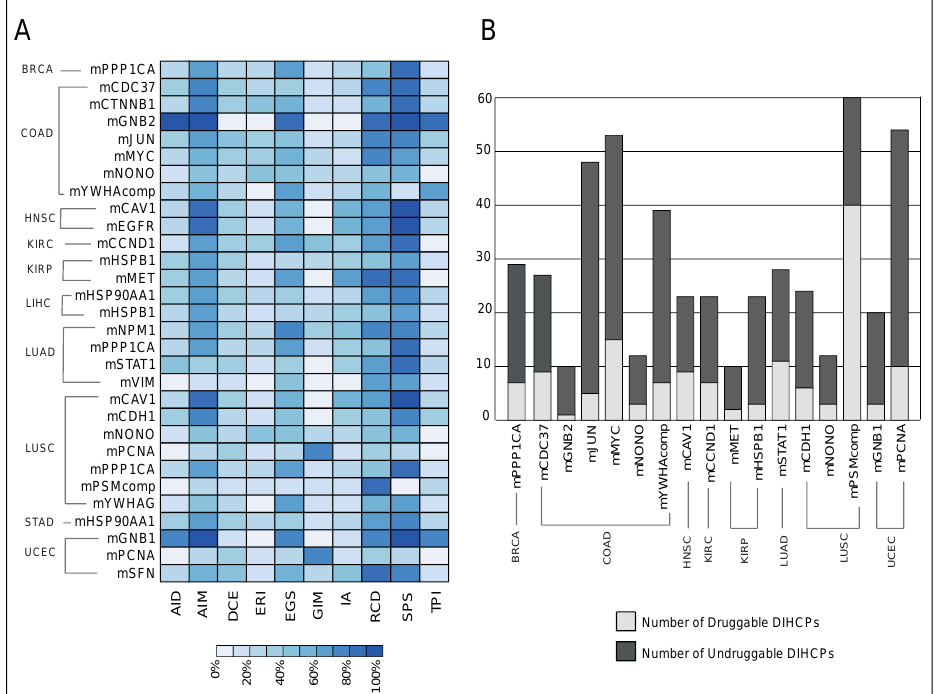
Figure 8. The hallmark enrichment and druggability analyses results. ( A ) The heat-map represents the hallmark enrichment results of the module’s differentially interacting hallmark of cancer proteins (DIHCPs). AID: avoiding immune destruction; AIM: activating invasion and metastasis; DCE: deregulating cellular energetics; ERI: enabling replicative immortality; EGS: evading growth suppressors; GIM: genome instability and mutation; IA: inducing angiogenesis; RCD: resisting cell death; SPS: sustaining proliferative signaling; TPI: tumor-promoting inflammation. ( B ) The druggability distribution of module’s DIHCPs. The bar graph indicates the number of DIHCPs, which are druggable (light grey bars) and undruggable (dark grey bars).